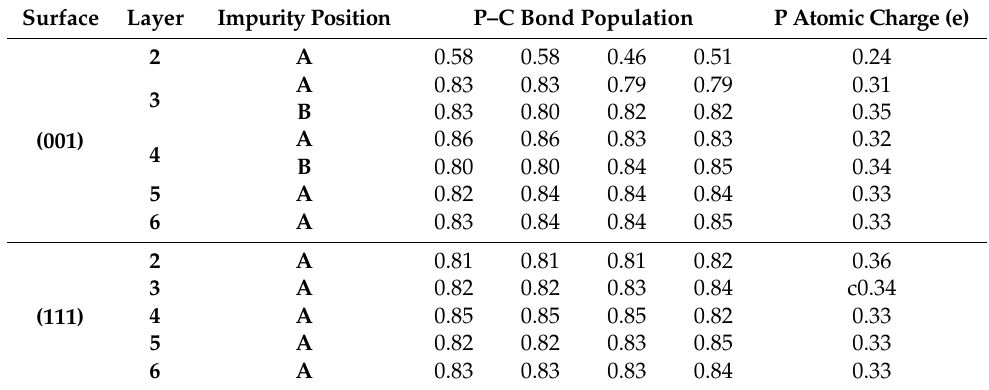
Table 5. Atomic charges and electron bond population of the single P with its surrounding C atoms.